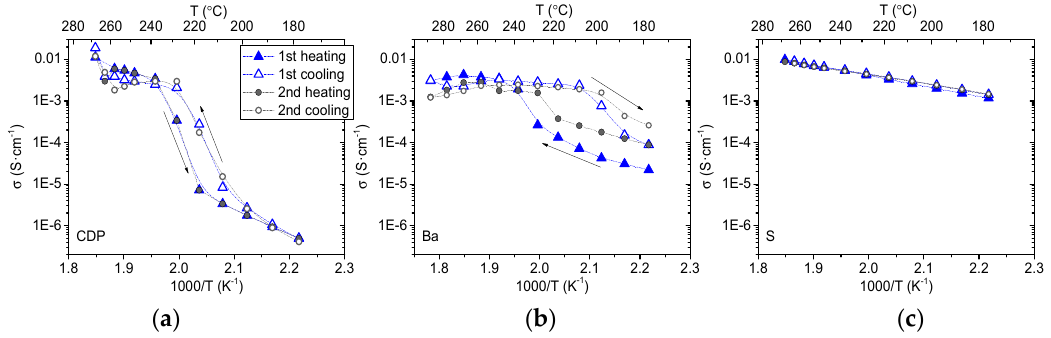
Figure 5. Conductivity of CDP ( a ), Ba ( b ) and S ( c ) substituted compounds as a function of temperature for two heating and cooling